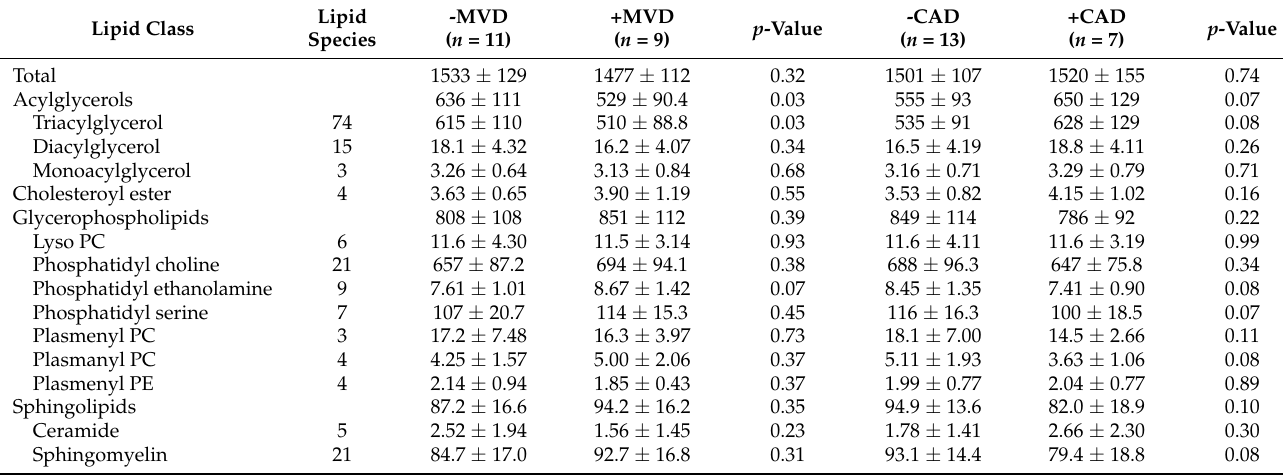
* All values are sums of individual lipid species and expressed in peak intensity × 10 3 and are shown as mean ± STD. p -values were obtained by a Student t -test. MVD, microvascular dysfunction. CAD, mild, non-obstructive coronary artery disease. Only classes only groups > 1 lipid species are shown. MVD, microvascular dysfunction; PC, phosphatidyl choline; PE, phosphatidyl ethanolamine.